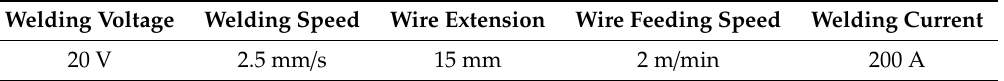
Table 2. Welding parameters during underwater wet welding